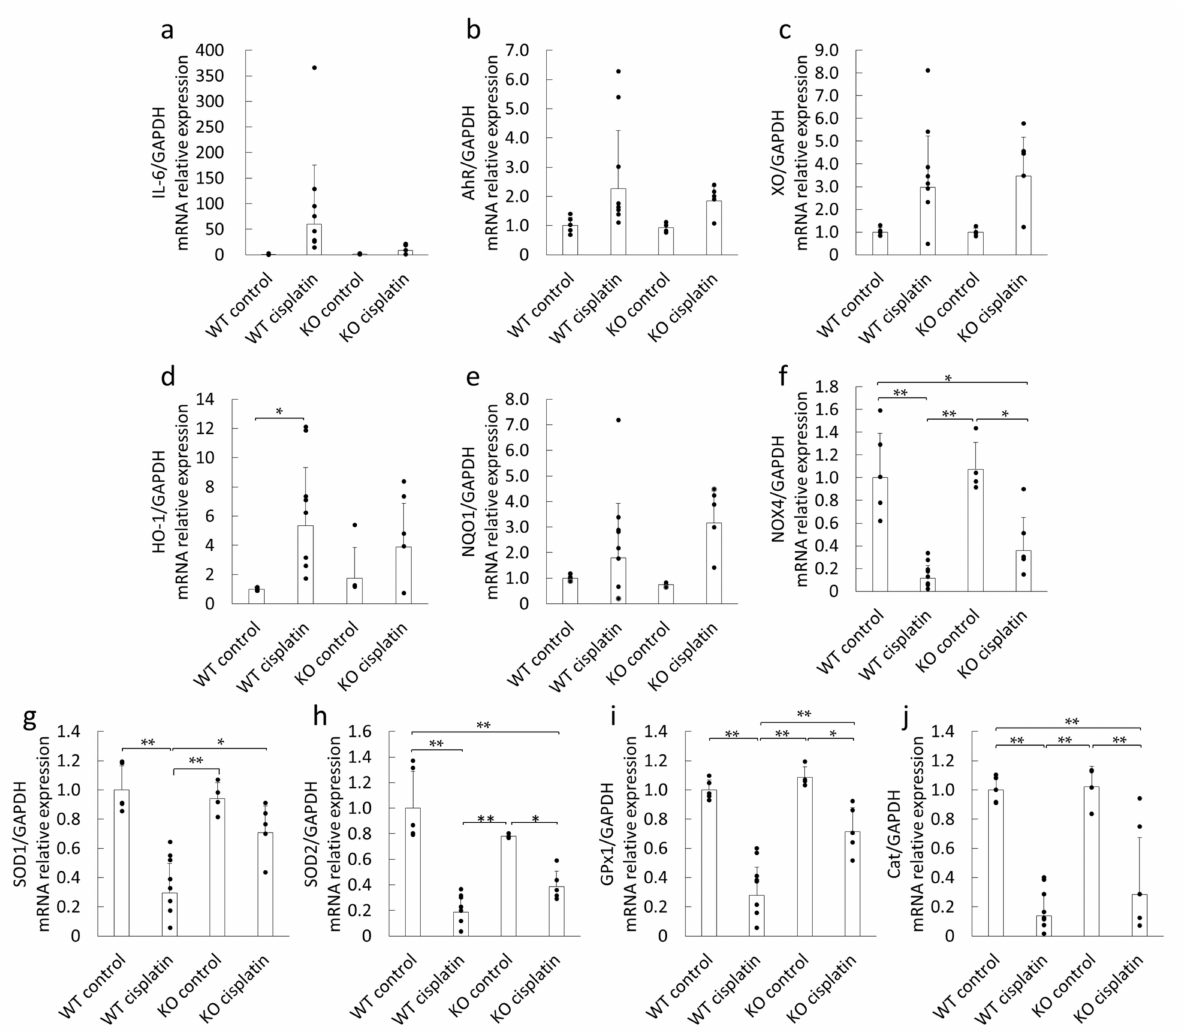
Figure 4. Effect of cisplatin treatment on mRNA expression of ( a ) interleukin-6 (IL-6), ( b ) aryl hydrocarbon receptor (AhR), ( c ) xanthine oxidase (XO), ( d ) heme oxygenase-1 (HO-1), ( e ) quinone oxidoreductase-1 (NQO1), ( f ) NADPH oxidase 4 (NOX4), ( g ) superoxide dismutase (SOD) 1, ( h ) SOD2, ( i ) glutathione peroxidase 1 (GPx1), and ( j ) catalase (Cat) in the kidneys of WT and Sult1a1 -/- (KO) mice: each column represents the mean ± S.D. of 4–8 mice. * p < 0.05; ** p < 0.01; N.S., not